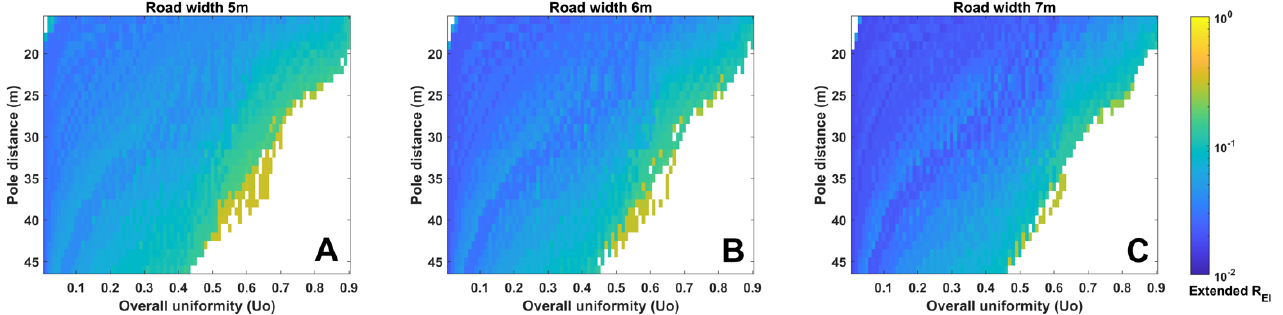
Figure 13. Overall uniformity of illuminance vs. pole distance vs. minimum extended R EI . The dark blue color illustrates a low extended R EI whereas yellowish colors refer to higher extended R EI levels. The white space equals a lack of technical solutions: ( A ) results for road width of 5 m; ( B ) results for road width of 6 m; ( C ) results for road width of 7 m.